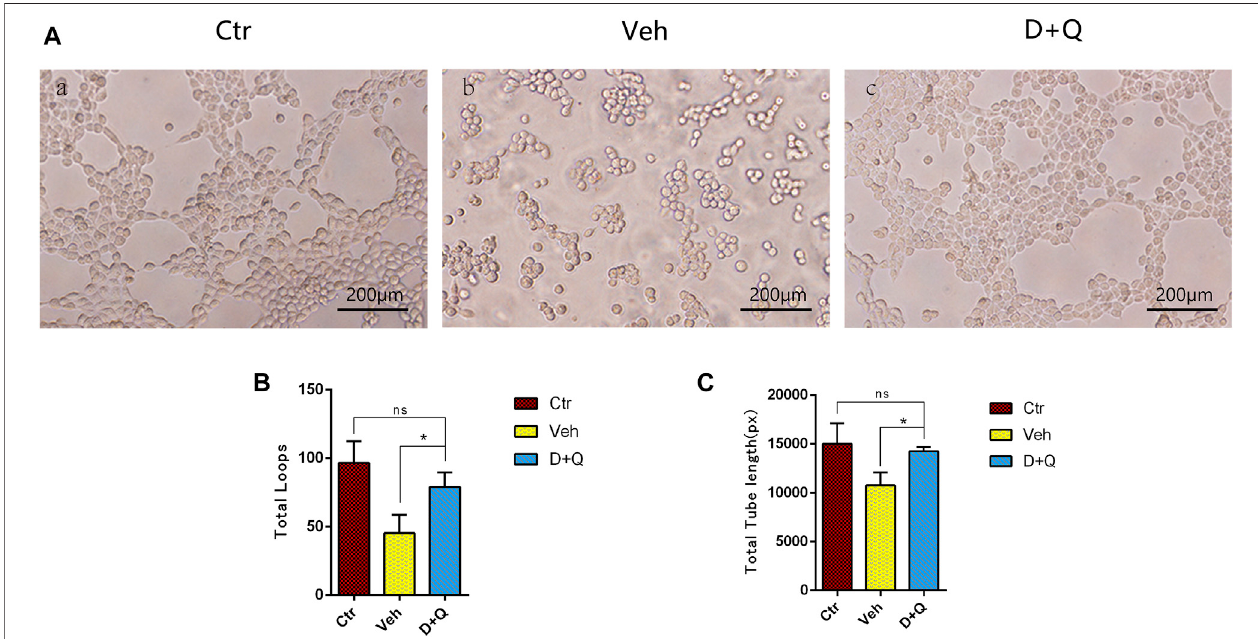
FIGURE 7 | The effect of extracellular matrix of vertebral bodies (ECM VBs) medium on the tube formation of HUVECs. (A) Microscopy image shows capillary-like structuresandabranchingnetworkafter6 hofexposuretotheECMVBsfromCtrgroup(left).Capillary-likestructuresandbranchingnetworkformationaresuppressed when exposed to the ECMVBs from Veh group (middle).D + Qexposuregets back to form capillary-likestructuresand looped branching networks after the 6 h culture period (right). Scale bar = 200 μ m. (B,C) Quantitative data of loops and length of tubes. Data are represented as mean ± SD. NP, nucleus pulposus; AF, annulus fi brosus; EP, endplate; Ctr, control group; Veh, vehicle group; D + Q, dasatinib and quercetin group. D + Q vs. Ctr group and Veh group; ns, no signi fi cance; *p <